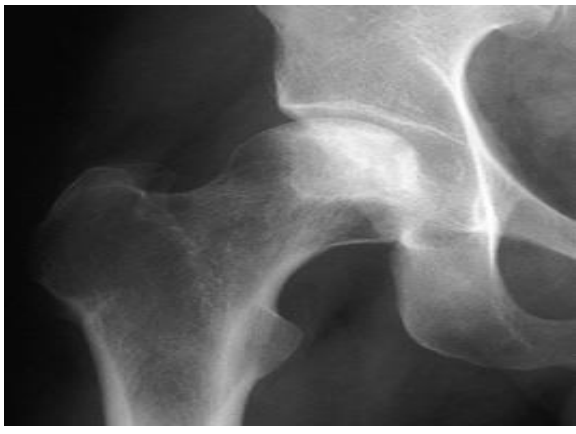
Fig. 2: Stage II osteonecrosis showing areas of sclerosis and radiolucency within the femoral head [13] .